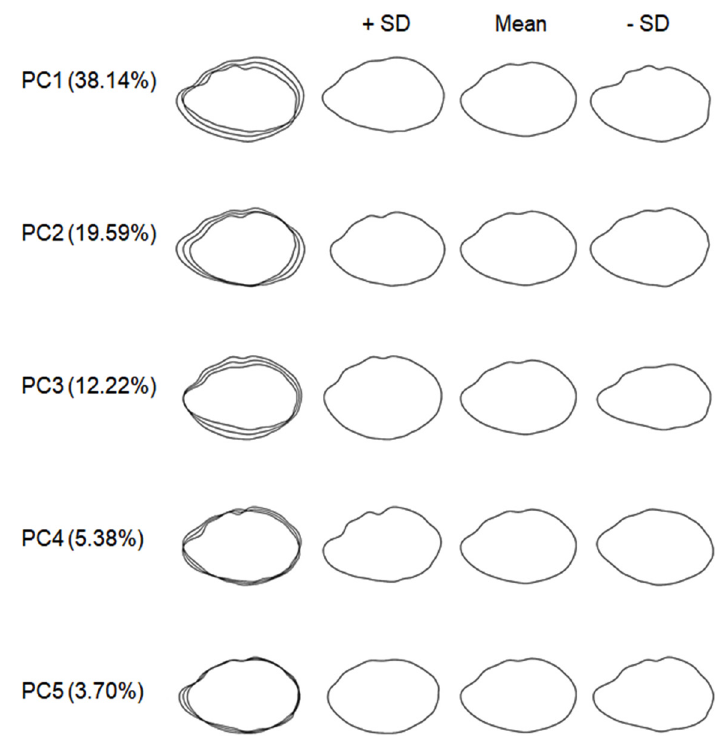
FIGURE 3 | Variation in shape (mean ± standard deviation – SD) in the sagittae of Cichla species explained by the first five principal components